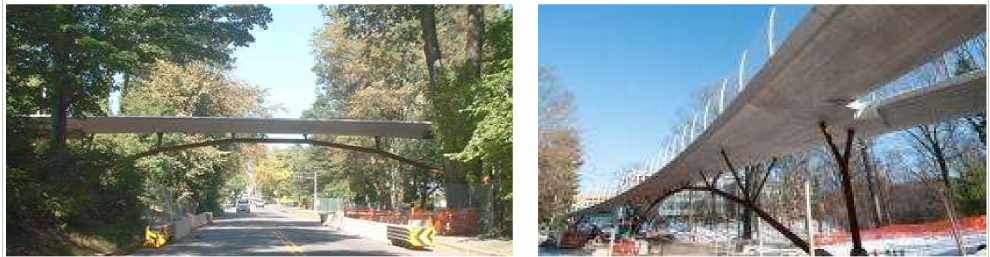
Figure 2. Photos of the Streicker Bridge at Princeton University, United States (Left: [26]; Right: